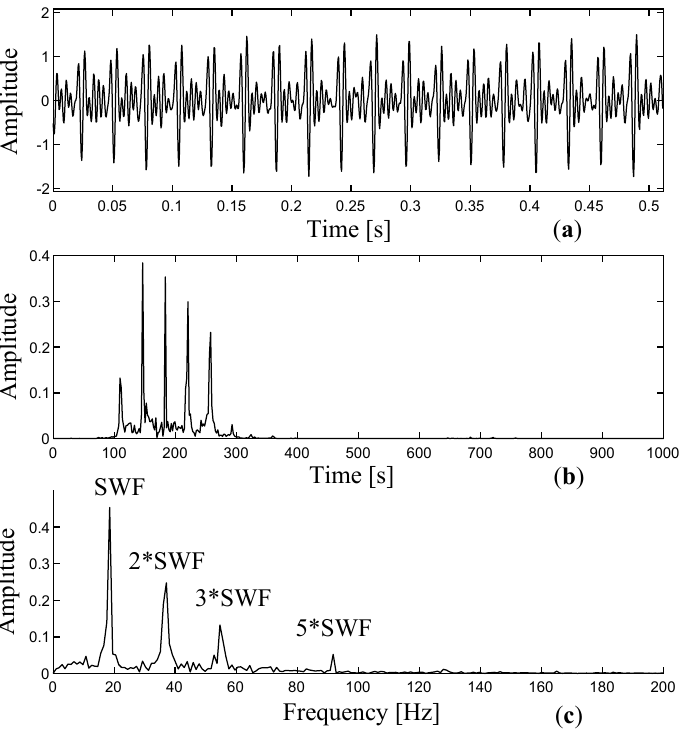
Figure 21. Analysis results of wp 3,2 ( n ) : ( a ) time domain waveform; ( b ) Fourier spectrum; and ( c ) Hilbert envelope spectrum.